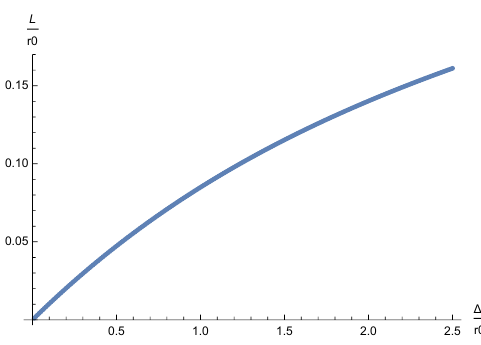
Figure 5 . Typical size of a string stretched between two D0 branes for the parameters R = 2, r 0 = 10, R c = 1 = 2 and C =